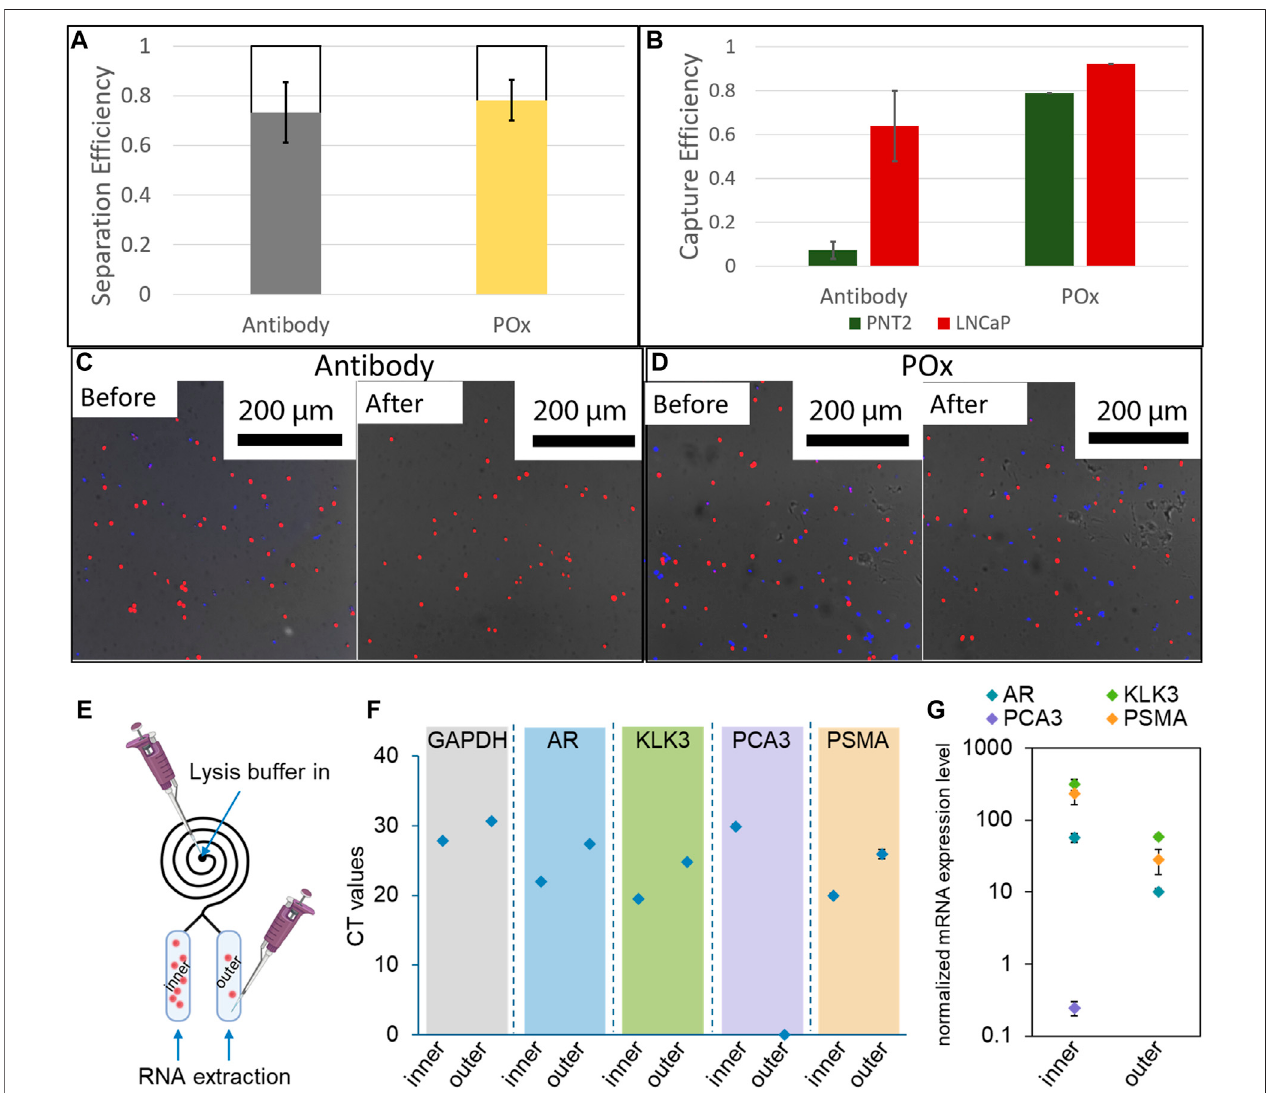
FIGURE6|(A) Cellseparationef fi ciencyin12loopspiralsat 300 μ l/min(n (cid:2) 3). (B) Selective captureef fi ciencyofamixtureofLNCaP andPNT2cellsinanti-PSMA functionalised channels with 1 mg/ml skim milk block and unfunctionalised POx. Fluorescence micrographs of capture surfaces before and after PBS rinse on antibody functionalised POx (C) and unfunctionalised POx (D) (n (cid:2) 3). A schematic illustration showing the captured cells lysis for RNA extraction (E) ; results of real-time RT-PCR showing the (F) CT values and (G) expression levels of targeted genes after normalized with GAPDH (n (cid:2)